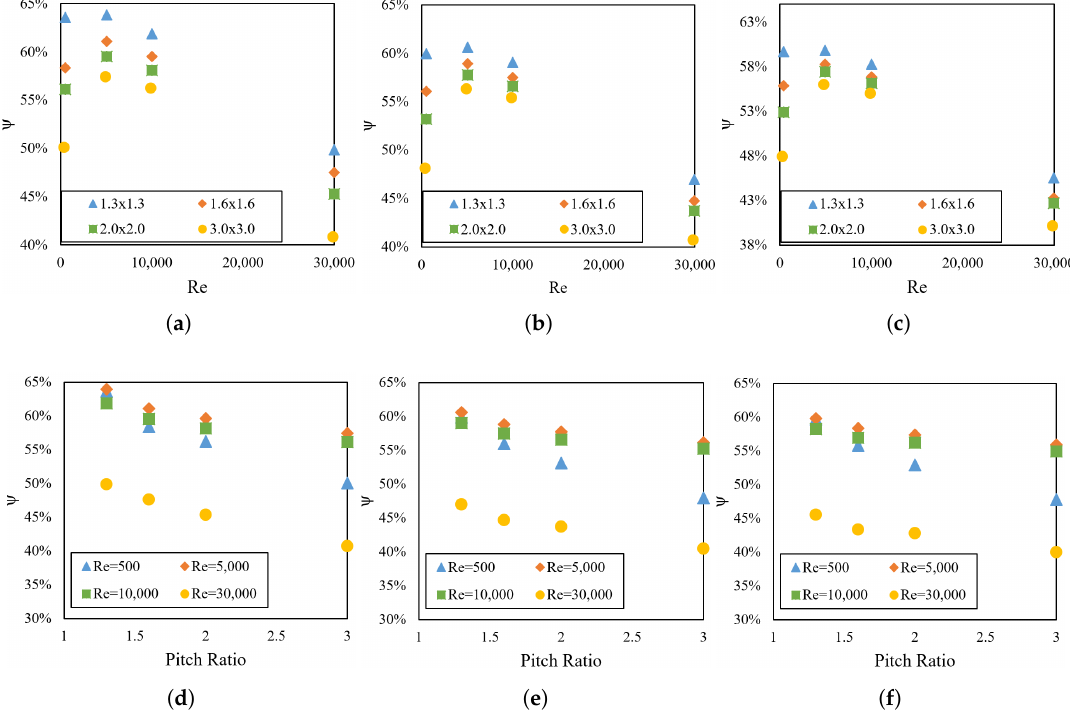
Figure 9. Exergy efficiency for ( a ) 8 tubes, ( b ) 4 tubes and ( c ) 3 tubes varying the Reynolds number for all four pitch ratios. ( d – f ) show the same 8-, 4- and 3-tube cases while varying the pitch